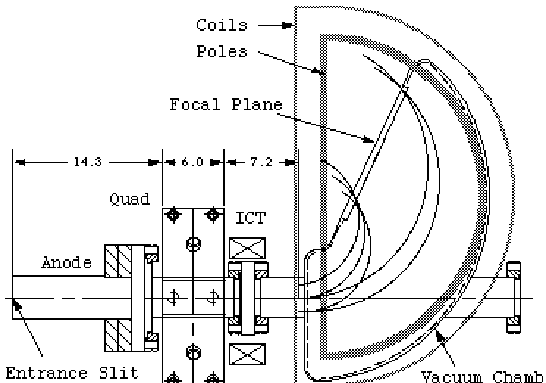
FIG. 7. Downstream beam diagnostics, with slit collimation in plasma arc anode, quadrupole lens, and high-resolution magnetic spectrometer with example trajectories.